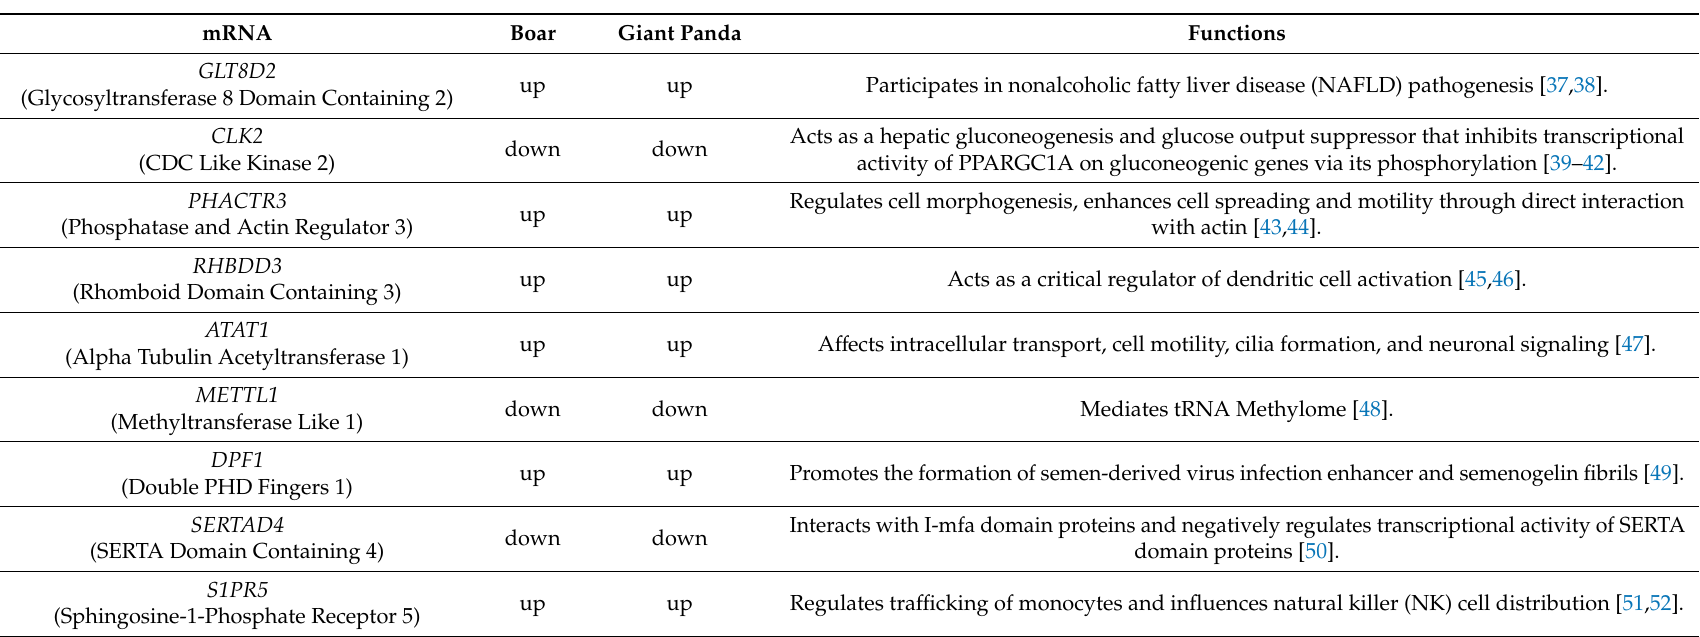
Table 3. The regulation of expression and the function of the nine DE mRNAs that exhibited the same trend of expression in boar and giant panda